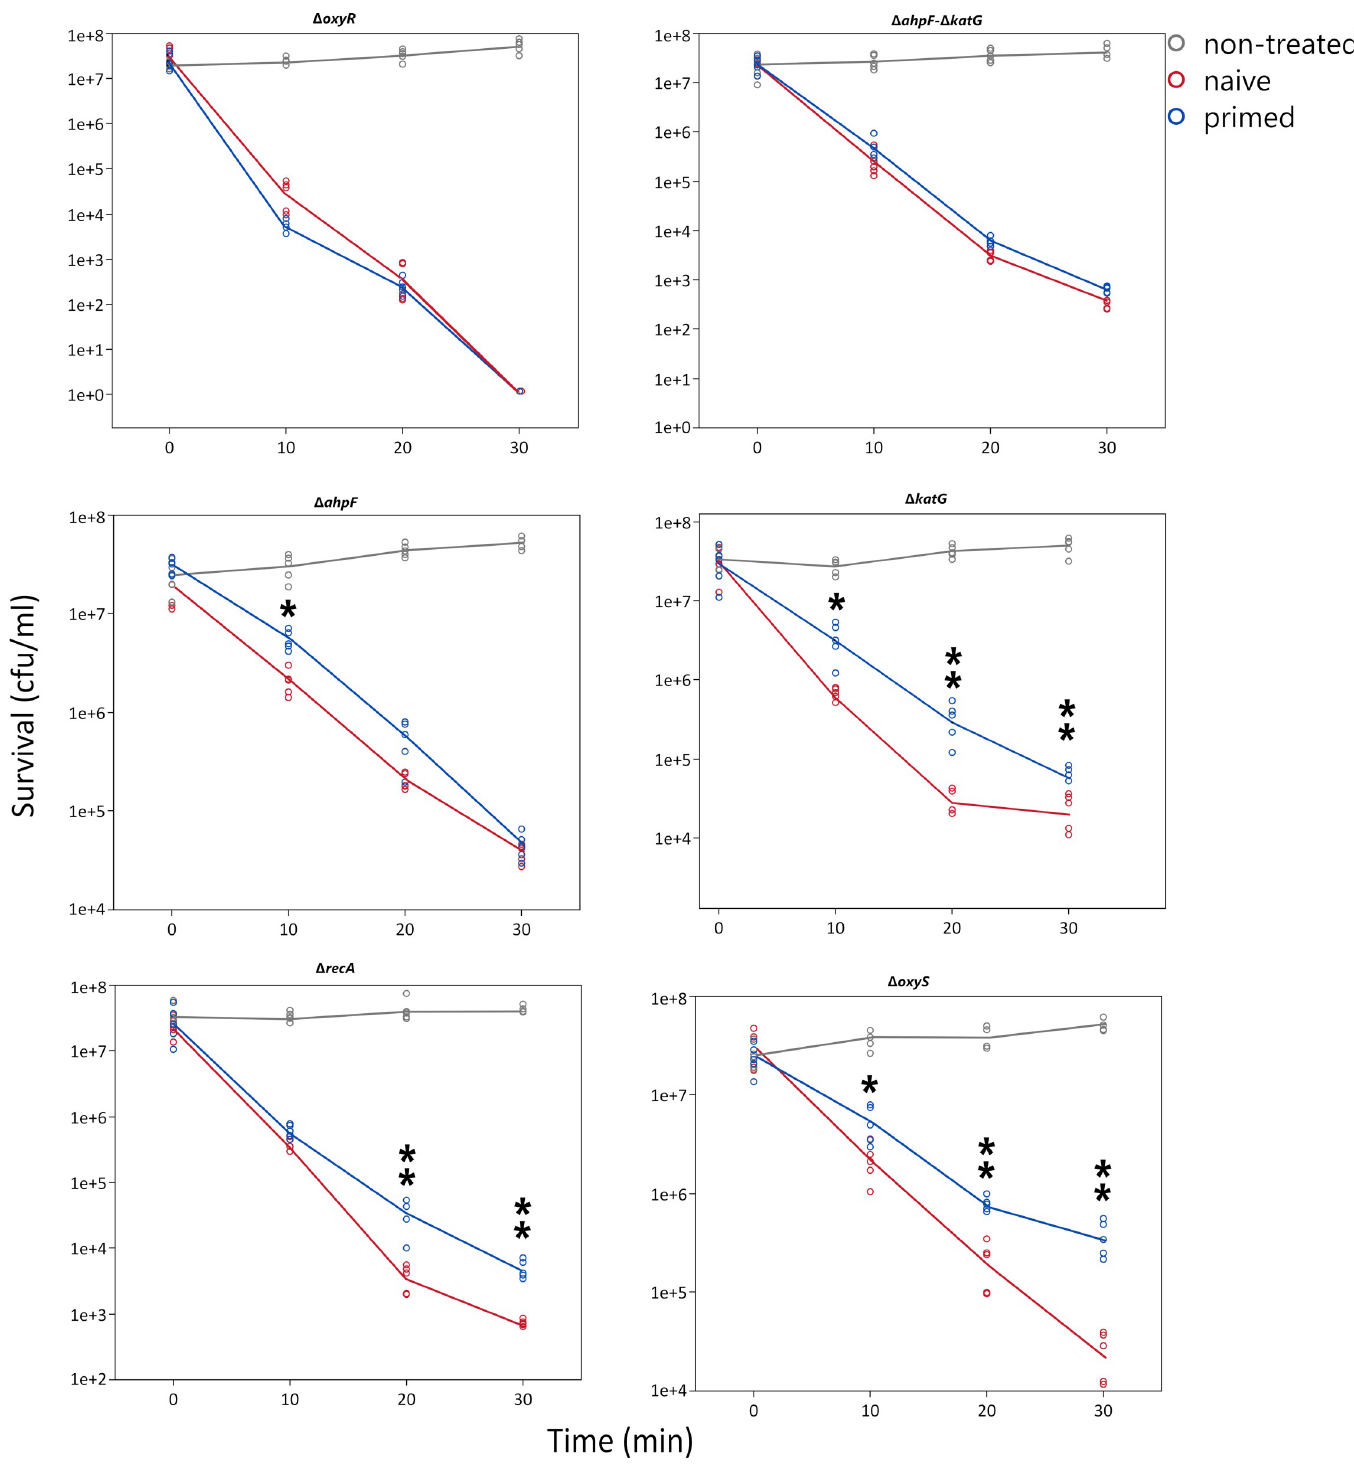
Fig 6. Priming experiments of different mutants of E . coli MG1655 in selected H 2 O 2- responsive genes. Asterisks represent significant differences (Welch’s test, one asterisk for p < 0.05 and two asterisks for p < 0.01). Only comparison between primed and non-primed groups are shown.